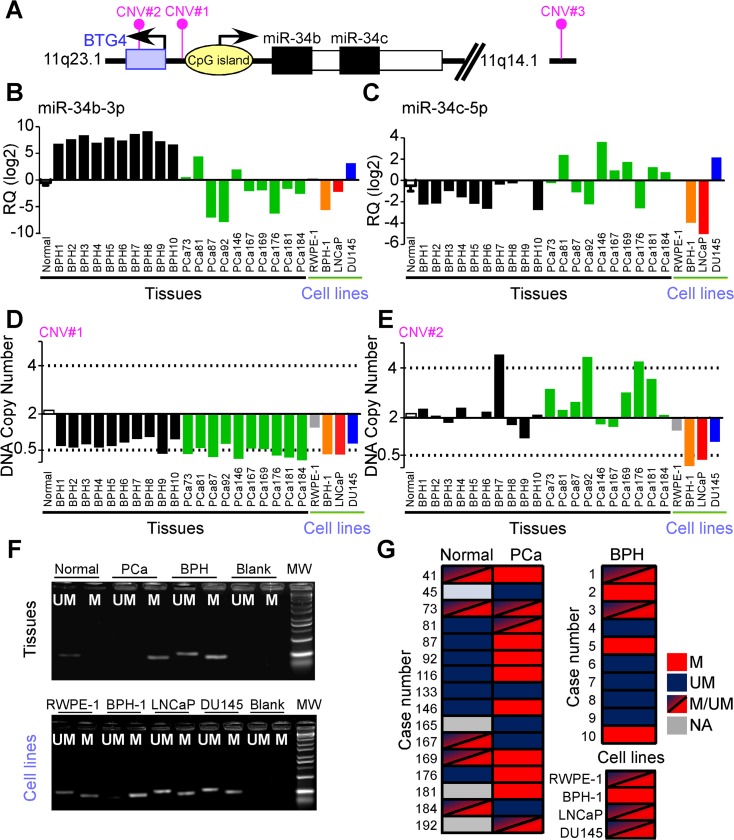
MIR34B/C gene analysis in prostate cells and human tissues.
A) Schematic diagram of human MIR34B/C locus on chromosome 11q. B, C) miR-34b-3p and miR-34c-5p expression in the indicated samples of normal prostate (pool of 10 specimens), benign hyperplasia (BPH), prostate cancer (PCa) or non-neoplastic (RWPE-1), hyperplastic (BPH-1) or tumor (LNCaP, DU145) prostate cell lines. D, E) Copy number of genomic DNA regions proximal to MIR34B/C locus (CNV#1; Hs00608392), or to the BTG4 gene (CNV#2, Hs03049129) was evaluated by qPCR in the same samples described in panels B, C. Cutoff values for significant loss or gain of targets DNA relative to a reference assay (RNase P) were defined as copies <0.5 or >4, respectively (no change: CNV = 2). F, G) Analysis of MIR34B/C CpG island epigenetic status was performed by methylation specific PCR in matched normal or neoplastic (PCa) prostate parenchyma, benign hyperplastic samples and prostate cell lines. A sample was considered partially methylated (M/UM) if amplified by both primer pairs. M, Methylated; UM, Unmethylated. Blank, no template control; NA, sample not available.